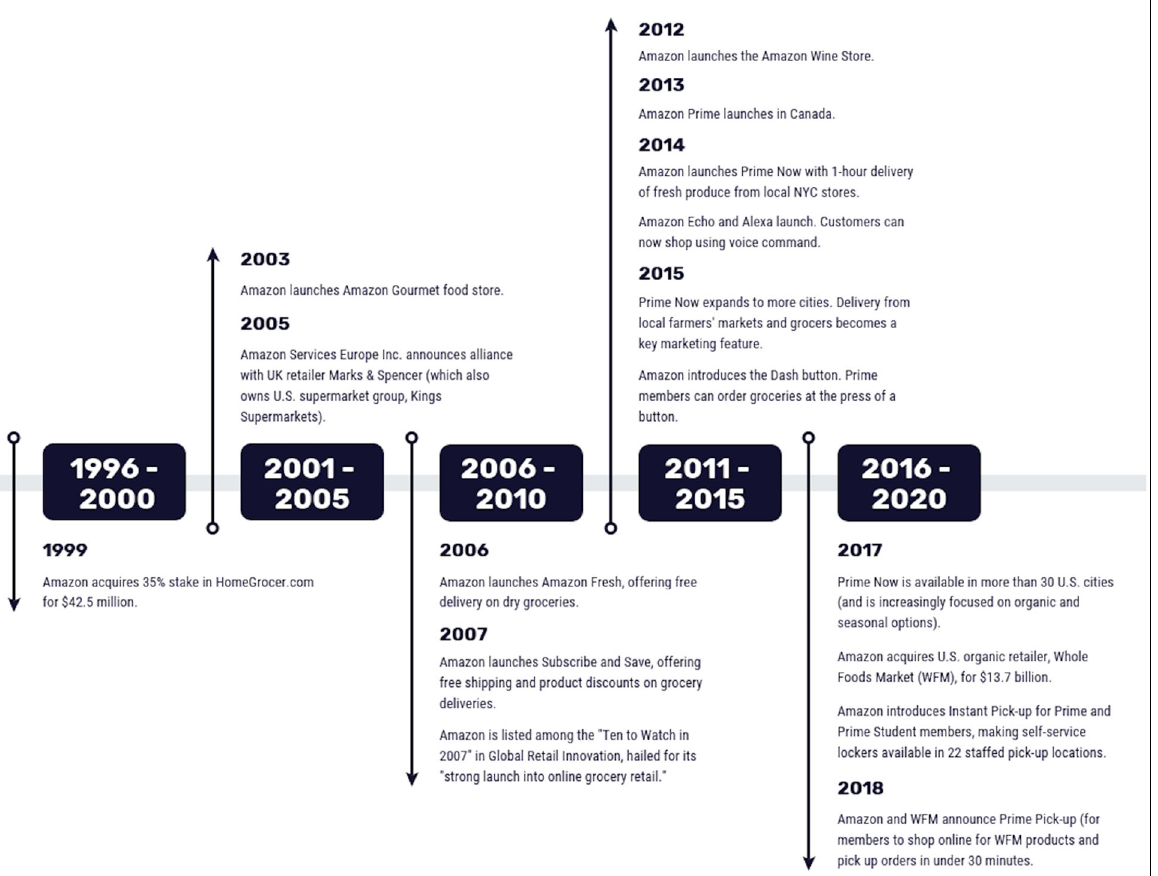
Figure 1. Amazon’s Transition into Food Retail,